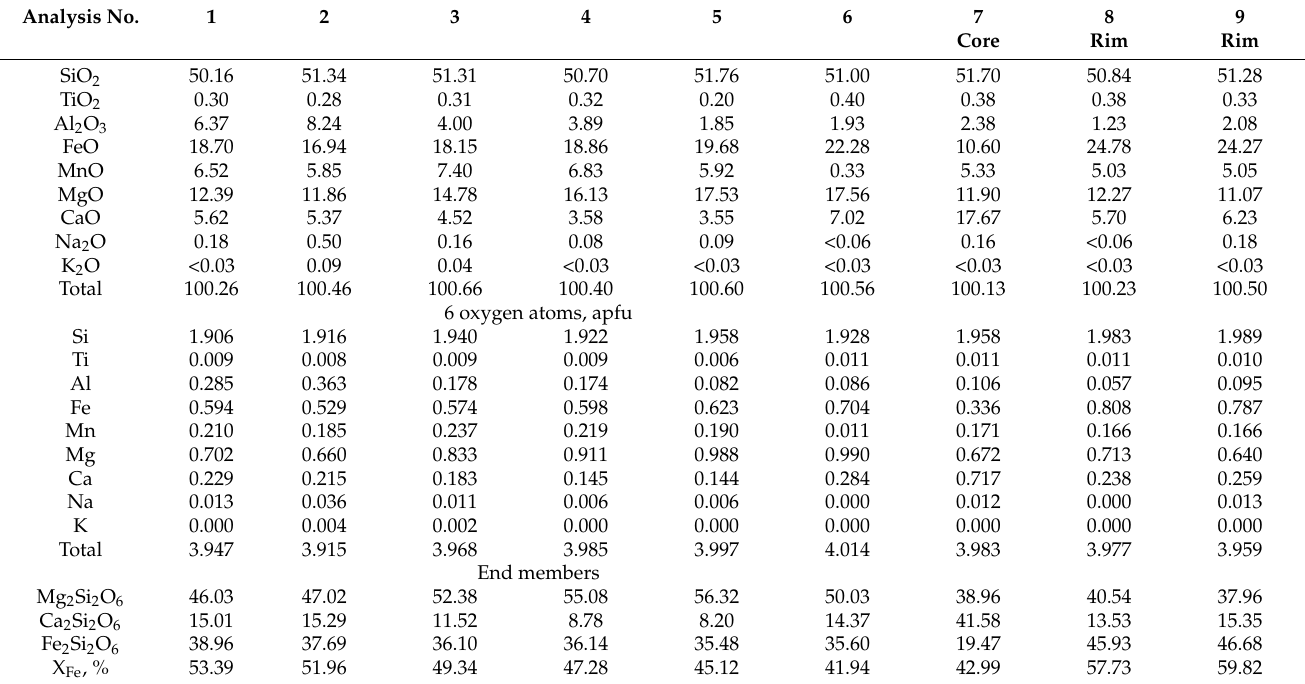
Table 4. Mineral chemistry of clinopyroxene from combustion metamorphic rocks of Karabetova Gora MV. EPMA data (in